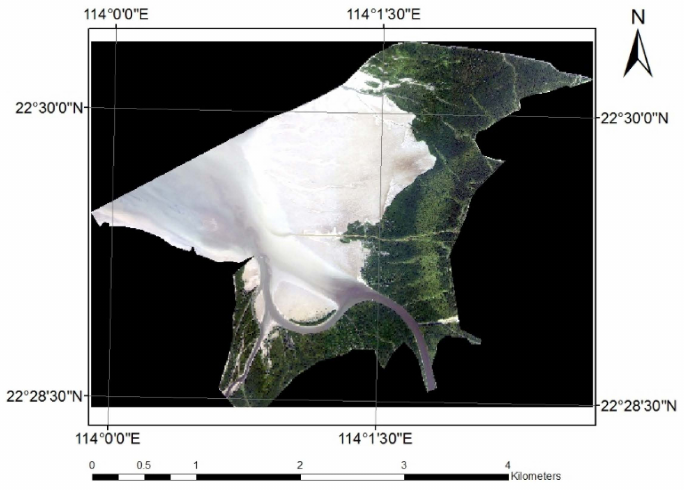
Figure 3. A true-colour image of the core